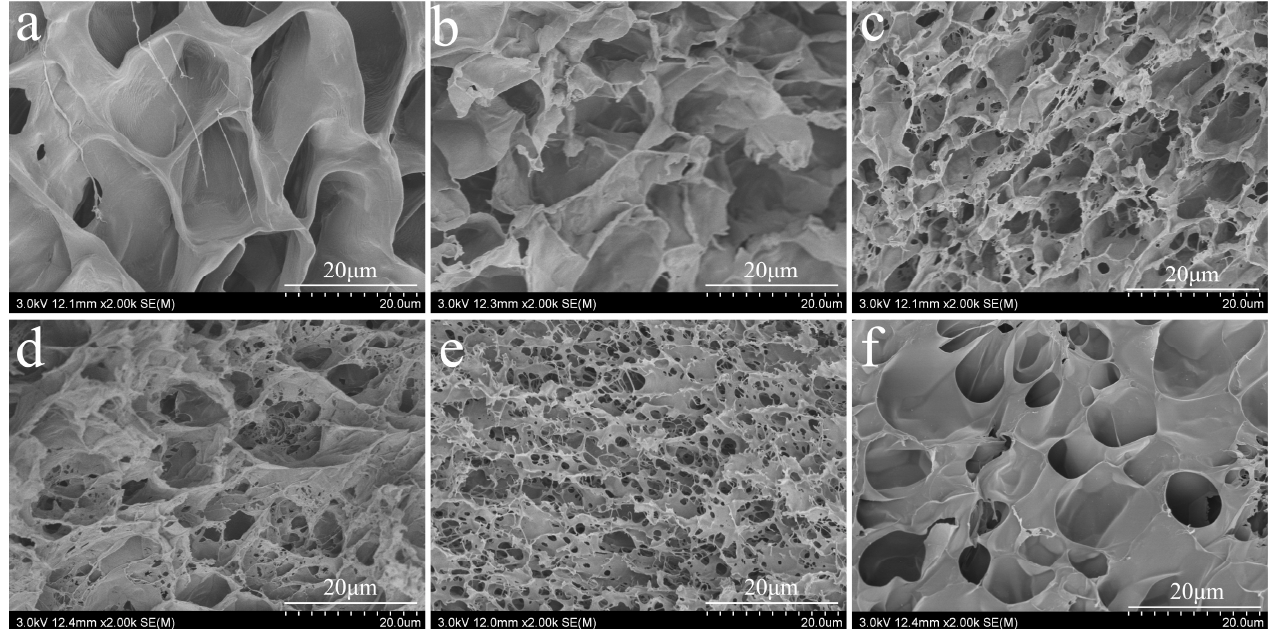
Figure 5. The cross-sectional morphology of CSF hydrogel: ( a ) pure SF, ( b – f ) the amount of ε -PLL added 1 wt.%, 2 wt.%, 5 wt.%, 10 wt.% and 15 wt.%. The solid content of SF and CSF solution is 3 wt.%, HRP concentration is 10 U/mL and H 2 O 2 concentration is 1 mM).